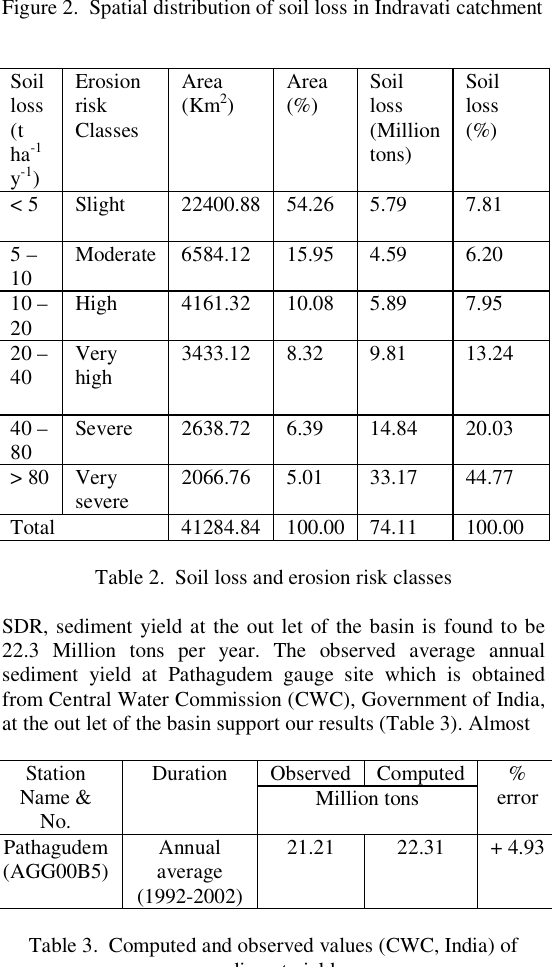
Figure 2. Spatial distribution of soil loss in Indravati catchment